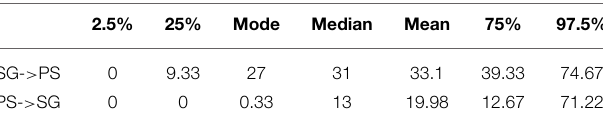
TABLE 3 | Posterior distributions of migration estimates from the full migration